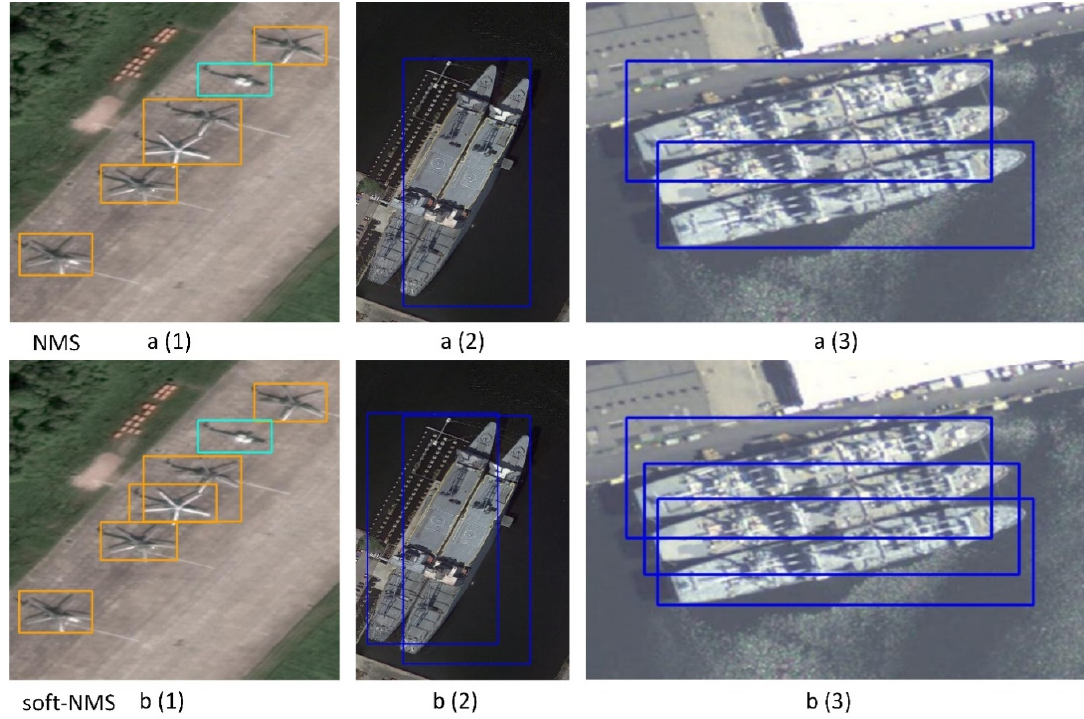
Figure 10. Detection results on the constructed RSD-GOD dataset when using non-maximum suppression (NMS) or soft-NMS in the proposed network.